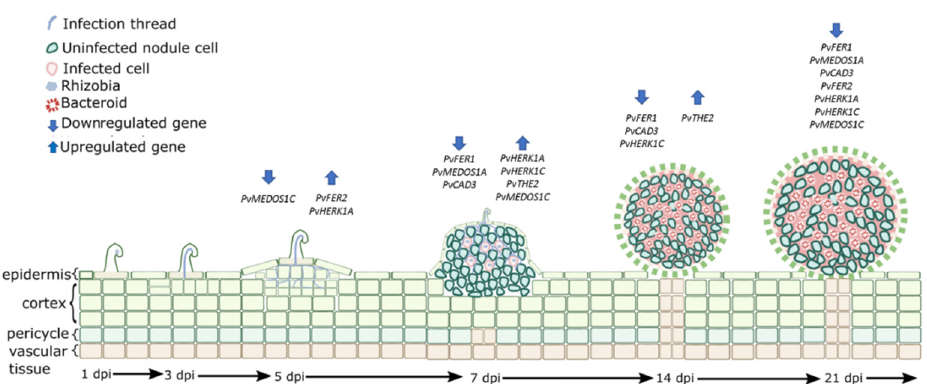
Figure 7. Putative roles of the eight CrRLK1L genes evaluated during nodule organogenesis in common bean. Graphic representation of the proposed roles of the eight CrRLK1L genes of common bean, based on the RT-qPCR data obtained in this study. Di ff erent stages corresponding to days post-inoculation (dpi) are observed. At the early stages, the bacteria and the root establish a molecular dialogue, which promotes curling of the root hair where the bacteria are enclosed in an infection chamber (not shown). One to three days before the bacteria become trapped, an infection thread (IT) is formed, which advances through the infected root hair cell, reaching the outer cortex of the root. Concurrently, cortex cells de-di ff erentiate and divide. By 5 dpi, dividing cells in the outer cortex generate a nodule primordium, whereas the IT branches toward the primordium. By 1 nitrogen fixation rates.